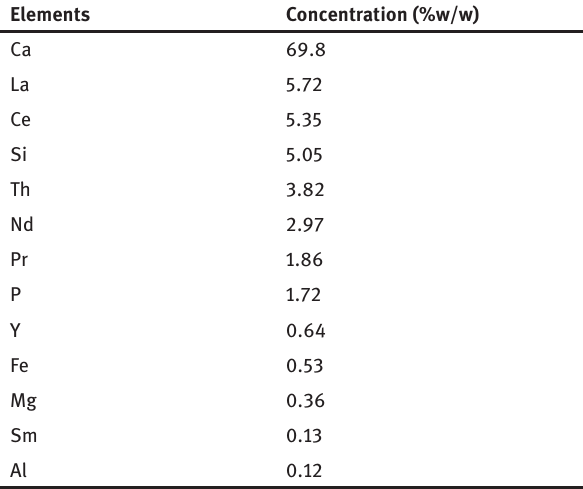
CO and Na CO 2 3 2 3